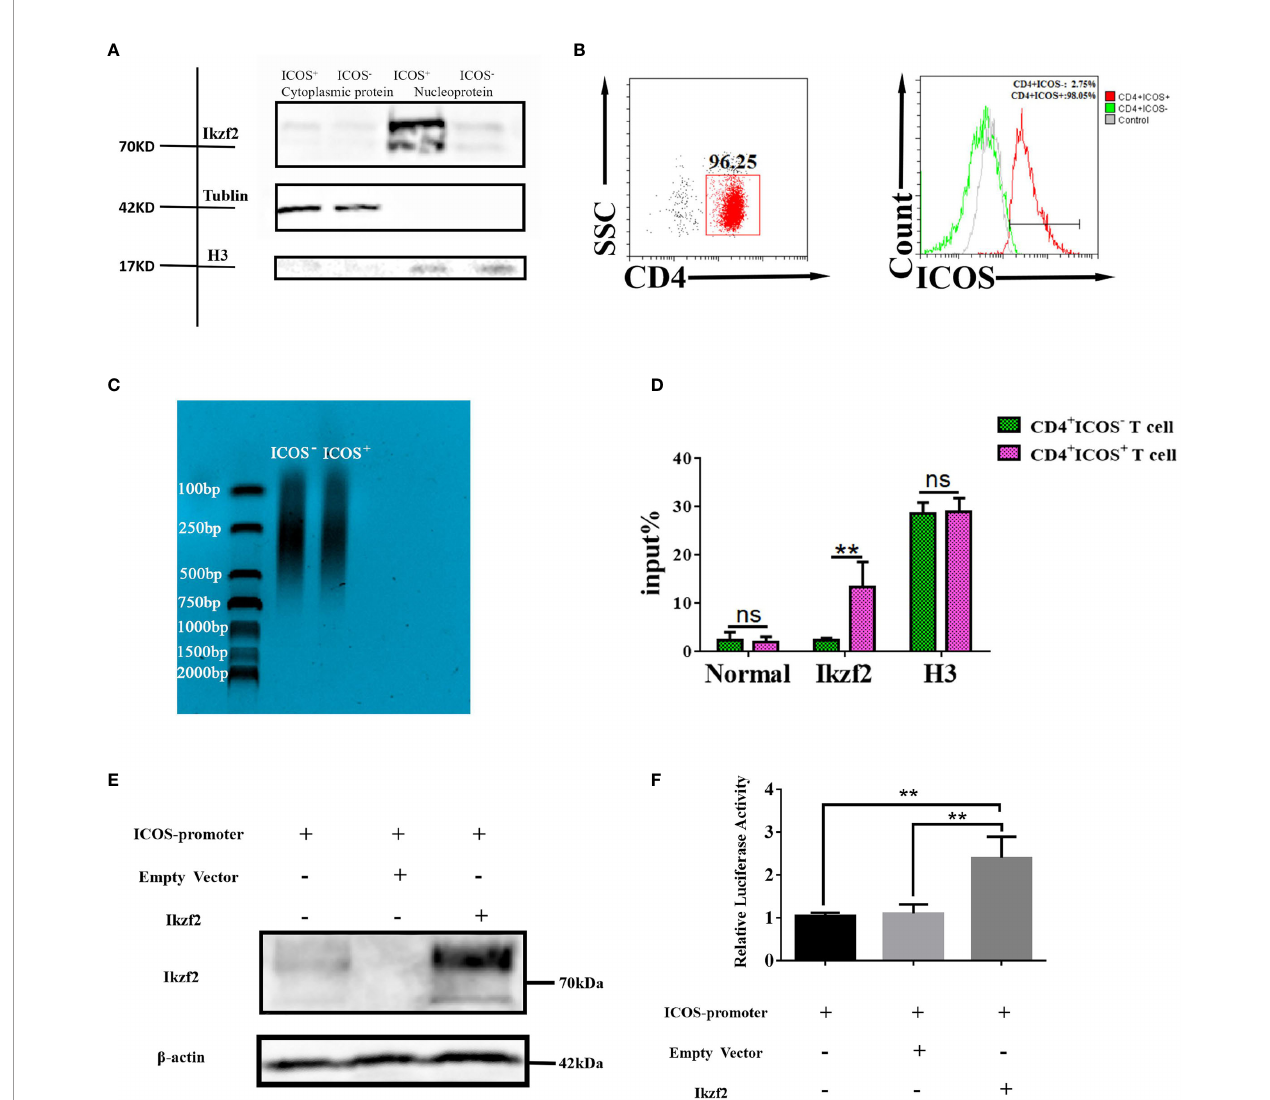
FIGURE 5 | Ikzf2 transferred into the nucleus of ICOS + Th cells and bound to the promoter icos gene after S. japonicum infection. (A) Five to 6 weeks after S. japonicum infection, splenocytes were isolated and stained by different fl uorescence-labeled antibodies. CD4 + ICOS + T cells and CD4 + ICOS − T cells were sorted by FACS, respectively. After the separation of nucleoplasmic proteins, the distribution of Ikzf2 was detected by Western blotting. Tubulin and histone H3 were used as cytoplasm and nucleus controls. (B) CD4 + T cells were stimulated with CD3 and CD28 mAb for 24 h, and ICOS + / − Th cells were selected by magnetic bead sorting. The expression of ICOS was detected by fl ow cytometry. (C) The DNA fragments of the sorted cells treated with the chromatin shearing kit were analyzed by DNA electrophoresis. The sheared length of DNA should be about 150 – 900 bp. (D) ChIP results were obtained by qRT-PCR. Anti-Ikzf2 mAb, positive control histone H3 rabbit mAb, and negative control normal rabbit IgG were added to pull down the promoter of ICOS, respectively. Percent Input = 2% × 2 (C[T] 2%Input Sample − C[T] IP Sample) . Data were shown as three samples in each group from one representative experiment, and experiments were repeated three times with similar results. (E) HEK293T cells were transfected with ICOS promoter reporter plasmids containing the fi re fl y luciferase and the renilla luciferase gene. Simultaneously, 500 ng of Ikzf2- fl ag plasmids and empty vectors were transfected into HEK293T cells. Twenty-four hours after transfection, IKZF2 expression were detected by Western blot. b -Actin was used as an internal reference protein. (F) The remaining cell lysates were used for the DLR test. The ratio of fi re fl y luciferase activity to Renilla luciferase activity was converted to relative luciferase activity. The means are from three independent experiments and the error bars are SD. ** P < 0.01, and ns , not signi fi cant ( P >